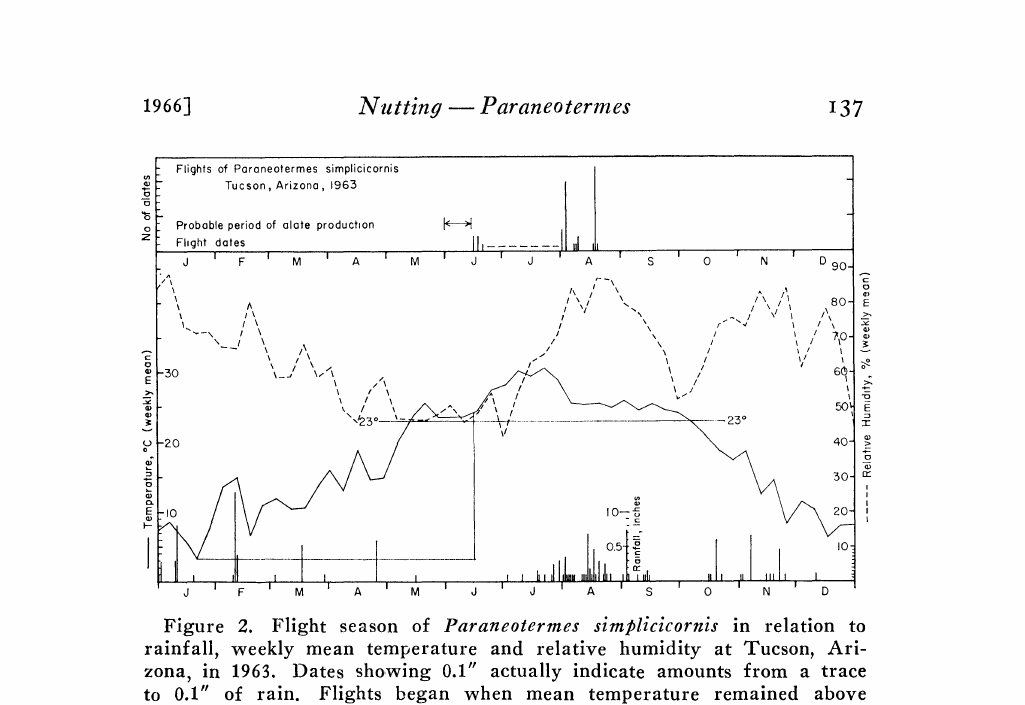
Figure 2. Flight season of Paraneotermes simHicicornis in relation to rainfall, weekly mean temperature and relative humidity at Tucson, Ari- zona, in 1963. Dates showing 0.1" actually indicate amounts from a trace to 0.1" o rain. Flights began when mean temperature remained above about 23C. The upper section shows the numbers of alates observed on each date during the flight season from June 15 to Aug. 19. No observa- tions were made between June 24 and August 1. Data on the maturation of alates were obtained from two colonies, one in the laboratory and one iv_ the